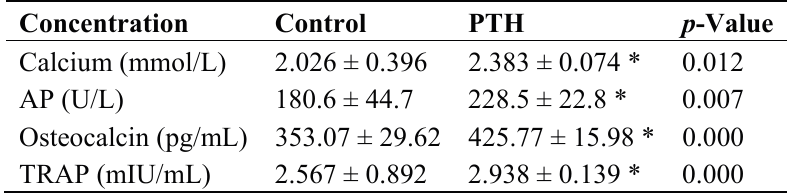
Table 1. Serum chemistry (mean ± SD). PTH, parathyroid hormone; AP, alkaline phosphatase; TRAP, tartrate-resistant acid phosphatase; * indicates significant difference between groups.